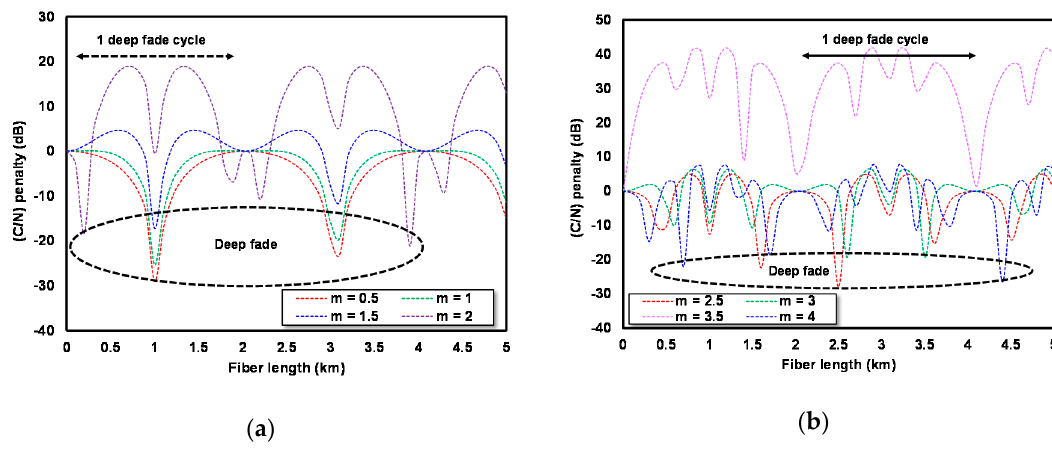
Figure 3. C / N penalty of the RoF link with ODSB modulation for ( a ) m ≤ 2 and ( b ) m > Figure 3. C/N penalty of the RoF link with ODSB modulation for ( a ) m ≤ 2 and ( b ) m > 2.